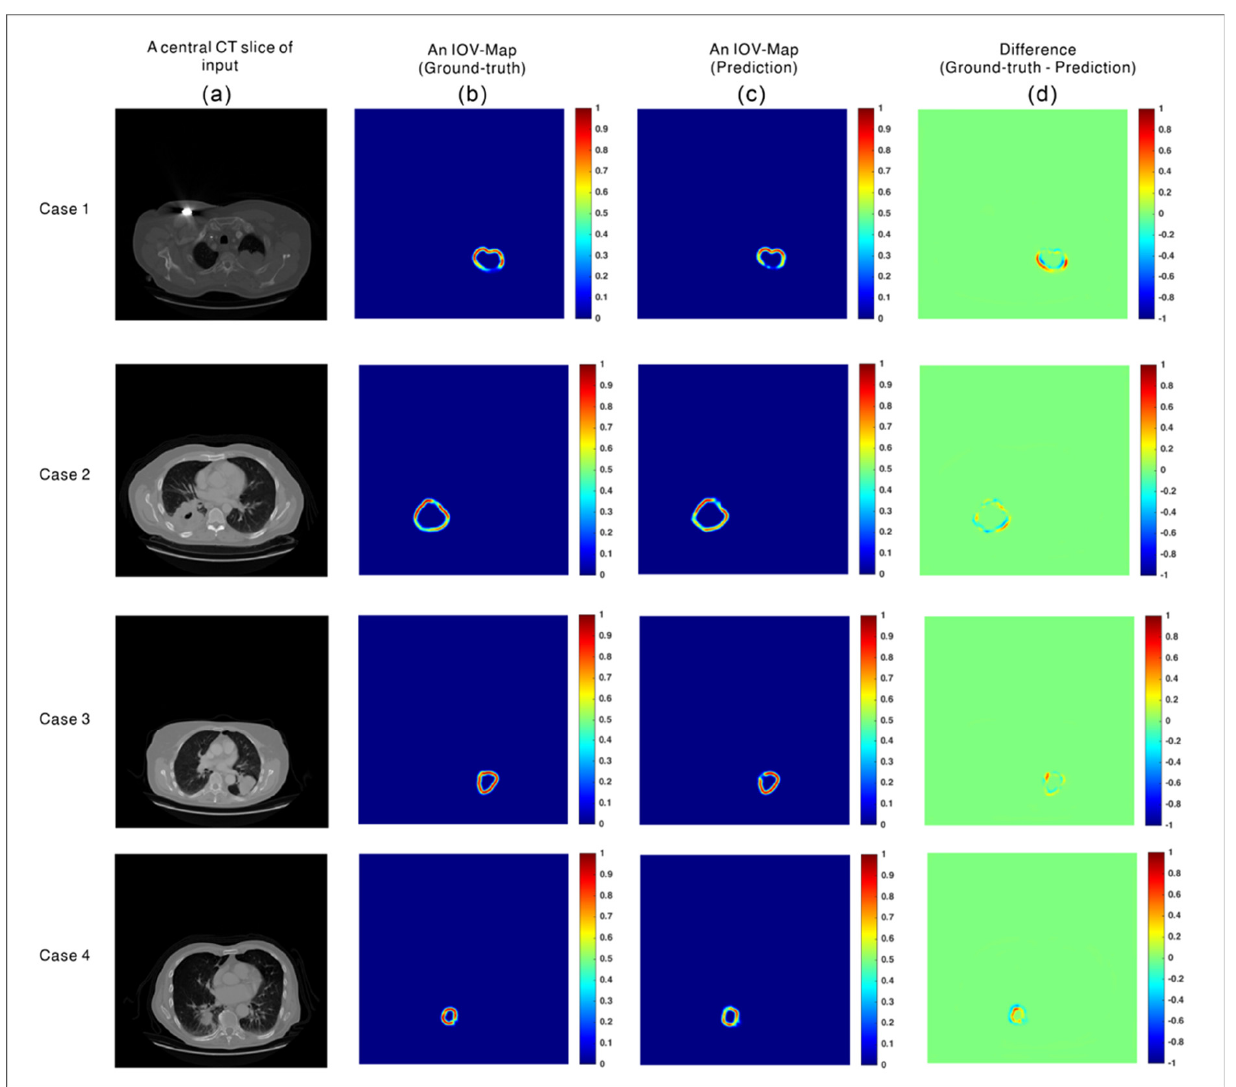
Figure 4. Samples of the test case for interobserver variability (IOV) map prediction: ( a ) central slice of the input, ( b ) ground-truth IOV map, ( c ) predicted IOV map, and ( d ) difference between the ground-truth and predicted IOV